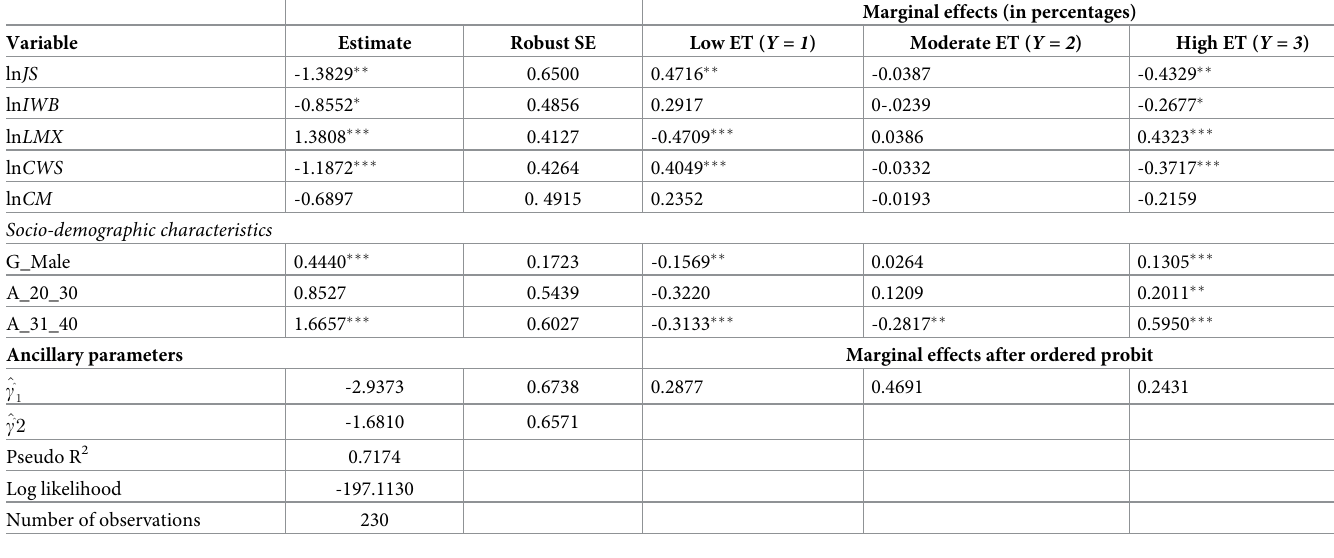
Table 4. Final ordered probit regression